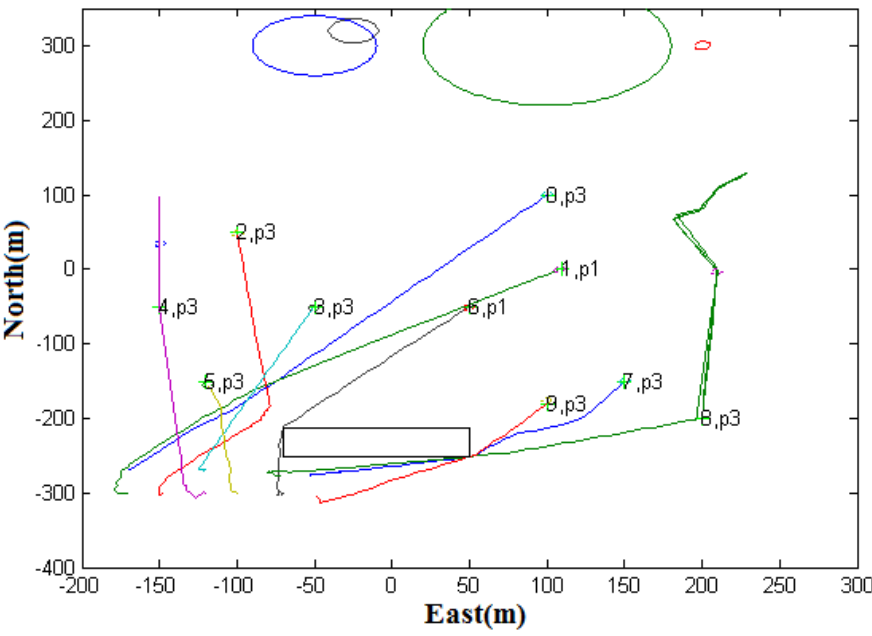
Figure 15. Case 2: Cooperative collision avoidance against polygonal obstacle. Symbols “i,pj” represent the i th UAV with priority level ( j = 1 at low priority; j = 3 at high